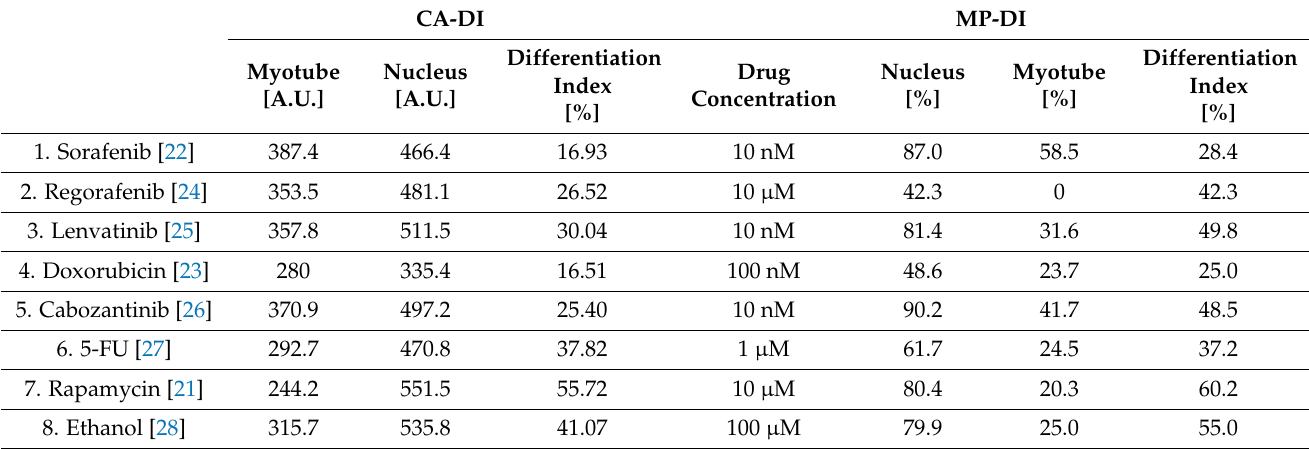
Figure 6. The comparison of two differentiation indexes (CA-DI and MP-DI). Table 1. AUC and differentiation indices for eight drugs tested.